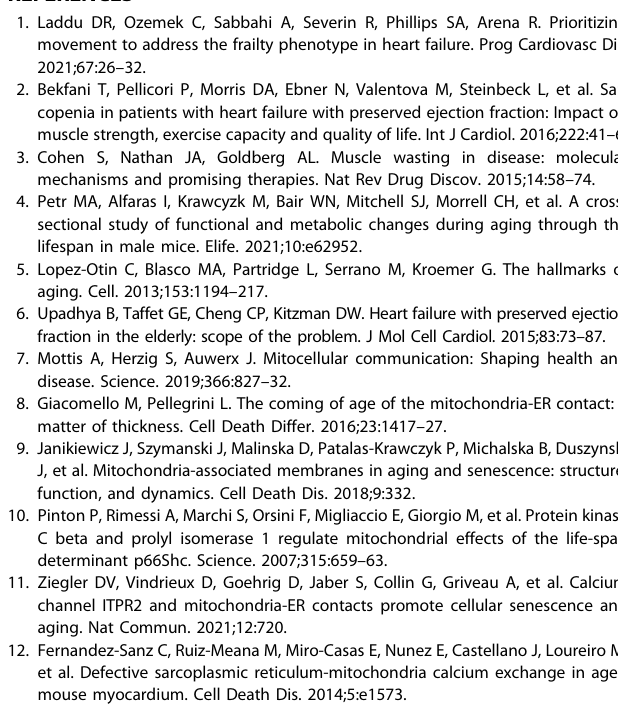
Fig. 6 ER-mitochondria membrane organization was perturbed in aged straited muscle. A STRING-based Protein – Protein Interaction (PPI) network of age-associated MAM proteins in straited muscle (the right panel). The age-associated proteins were obtained from meta-analysis of combined heart and GA muscle MAM proteome, and visualized as a PPI network using the stringApp in Cytoscape with K-means clustering. In the right panel, node color represented different K-means clusters. The zoomed panel to the left showed a subnetwork of proteins involving ER-mitochondria membrane organization, in which upregulated proteins were colored in red, and downregulated proteins in blue ( n = 3 per group, 4-month-old vs. 24-month-old). In the entire fi gure, node size showed signi fi cance of the age-associated MAM proteins. B Heatmap showing altered expression pro fi le of MAM proteins involving ER-mitochondria membrane organization. Fold changes of protein levels in the 24-month-old group relative to their 4-month-old control were denoted beside the heatmap. NS, not signi fi cant. C Immunoblot analysis showing signi fi cantly altered abundance of MIC60, MTX1, SAMM50, VDAC1 and GRP75 in MAM and pure mitochondrial fractions during aging. Right panel: Age-related abundance changes of the indicated proteins in the MAM fractions relative to the pure mitochondria fractions. The values within the bars showed the mean fold changes of protein levels in the 24-month-old group compared to the 4-month-old control and normalized to TOMM20. ( n = 3 independent experiments, the variance was similar between groups. * P < 0.05; ** P < 0.01). D A putative responsive network of MAM proteome during aging. The circles represented deregulated MAM proteins in aging straited muscle, with inner circles indicated GA muscle and outer circles indicated heart. The upregulated proteins were colored in red, and downregulated proteins in blue (4-month-old vs. 24-month-old). Mito. mitochondrial, OXPHOS oxidative phosphorylation, TCA tricarboxylic acid, MICOS the mitochondrial contact site and cristae organizing system, SAM the sorting and assembly machinery complex, MIB